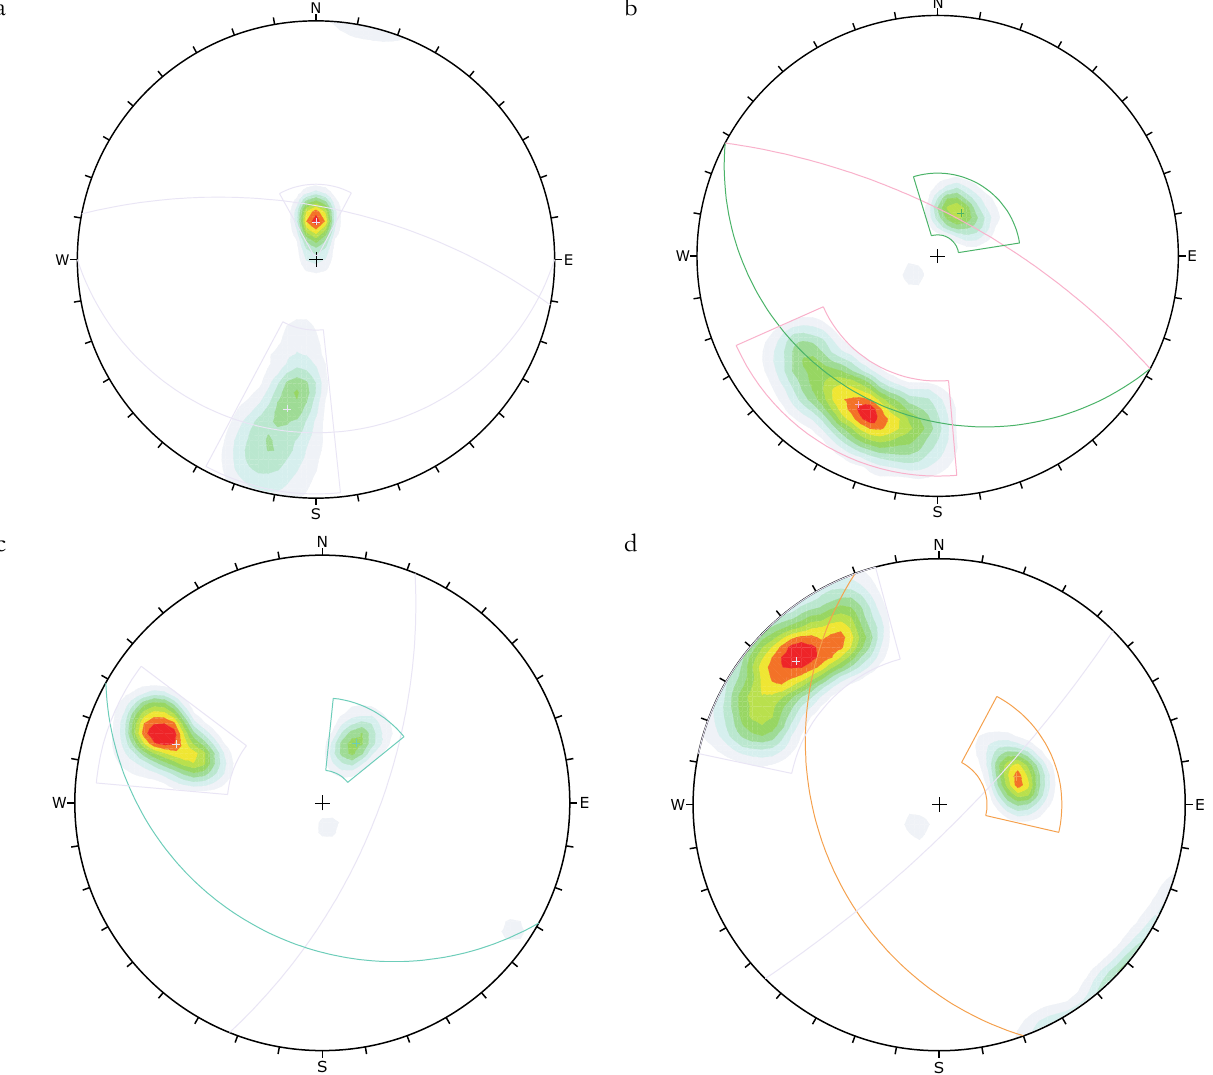
Figure 7: The spatial position of the fracture using contour plot of pole vectors in two studied areas for two scales; a) the results of field surveying for Region 1, b) the results of CT-scan of core samples for region 1, c) field surveying results for region 2, d the results of core samples for region